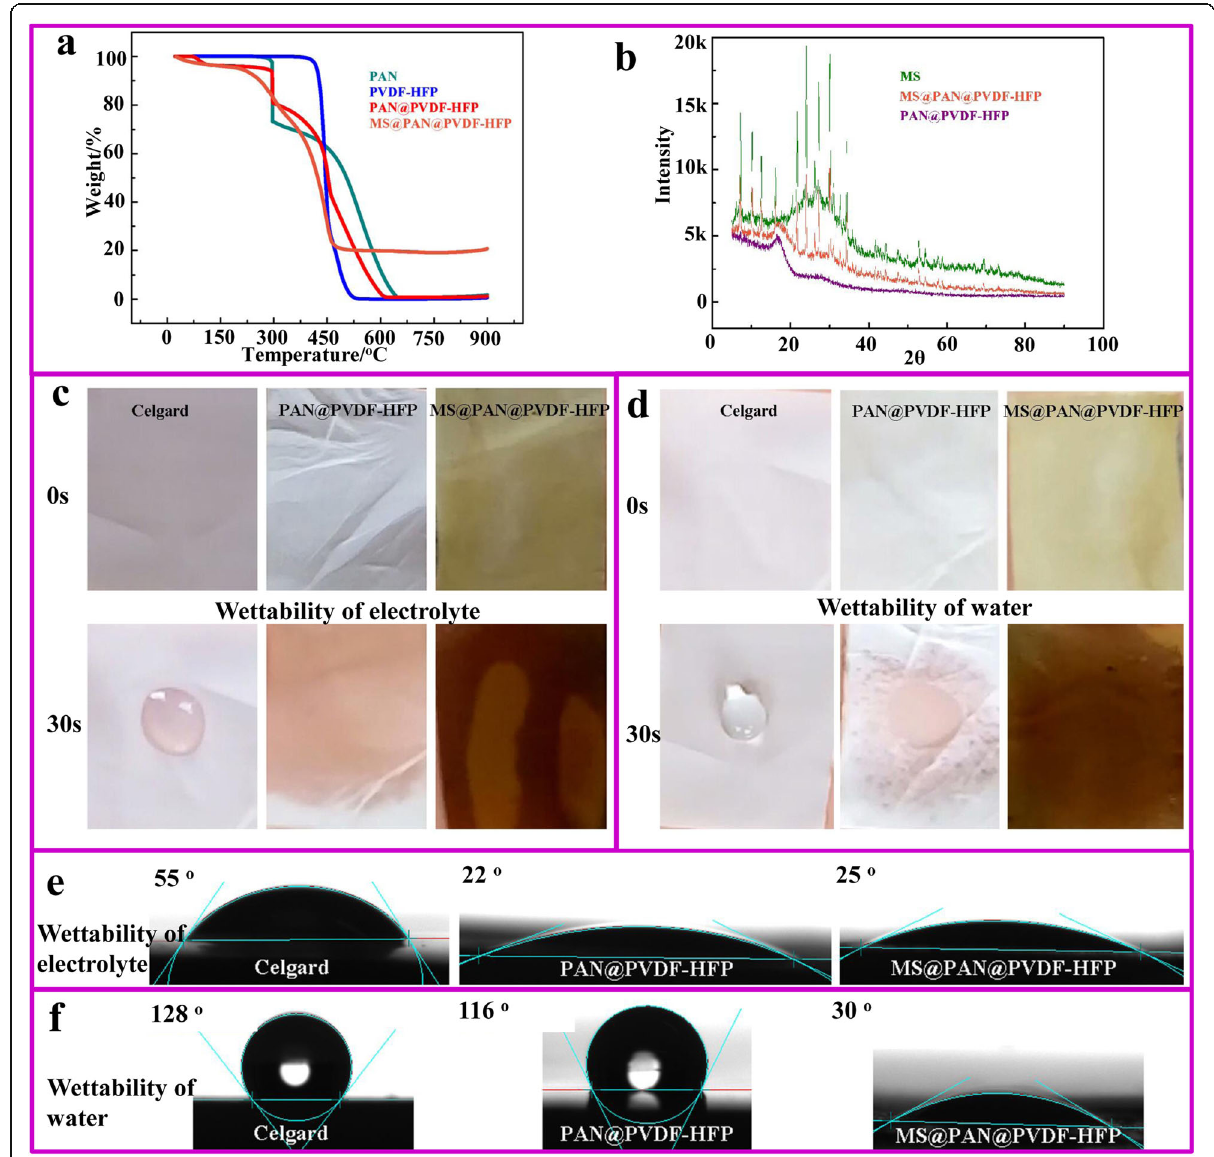
Fig. 3 a XRD pattern of MS, PVDF-HFP@PAN, and MS@PVDF-HFP@PAN. b TGA curves of PAN, PVDF-HFP, PVDF-HFP@PAN, and